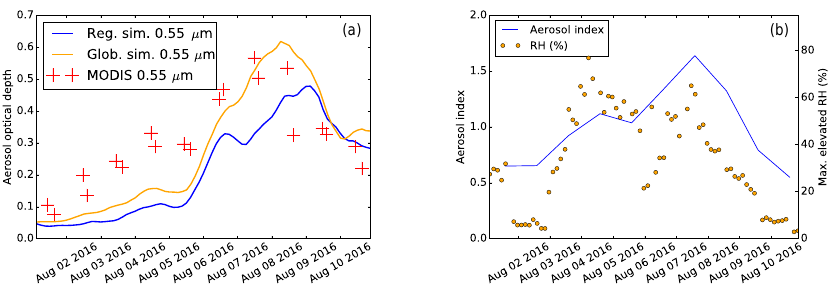
Figure 8. (a) Aerosol optical depth, averaged over the regional domain. We did not attempt to correct sampling biases: retrievals in the MODIS aerosol optical depth domain average are not given greater weight when they are further away from other retrievals, so cloudy areas where there are few AOD retrievals do not contribute as much to the domain average as areas where the skies are clear and there are many retrievals. As large areas of the regional domain have no retrievals because they are cloudy, at the edge of swaths, or in the glint regions, this bias is probably significant, but it is likely to explain some of the scatter, rather than the trend, shown in the figure. (b) OMPS aerosol index in a 7 × 7 ◦ latitude–longitude box centred on Ascension Island and maximum relative humidity above the boundary layer, measured by the ARM site sondes (Holdridge et al., 2016b).